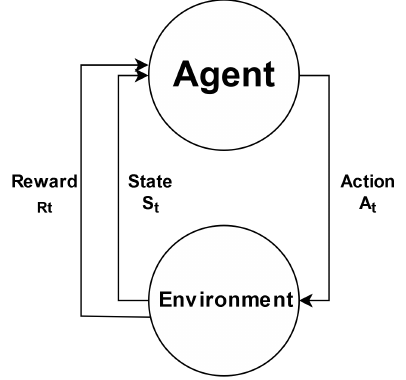
Figure 6. Agent–Environment interaction in a Markov decision process (MDP) adapted from